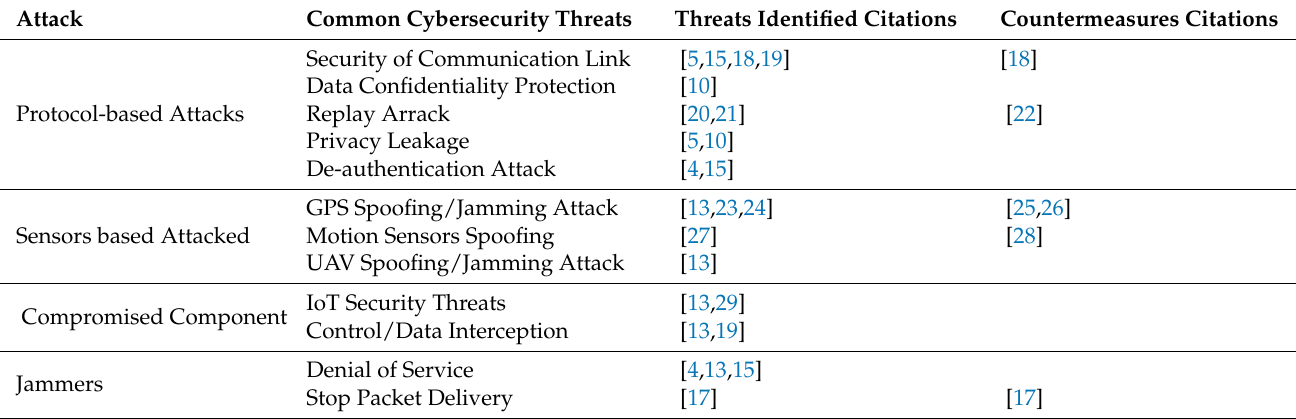
Table 1. Typical cybersecurity and data privacy threats to smart drones.